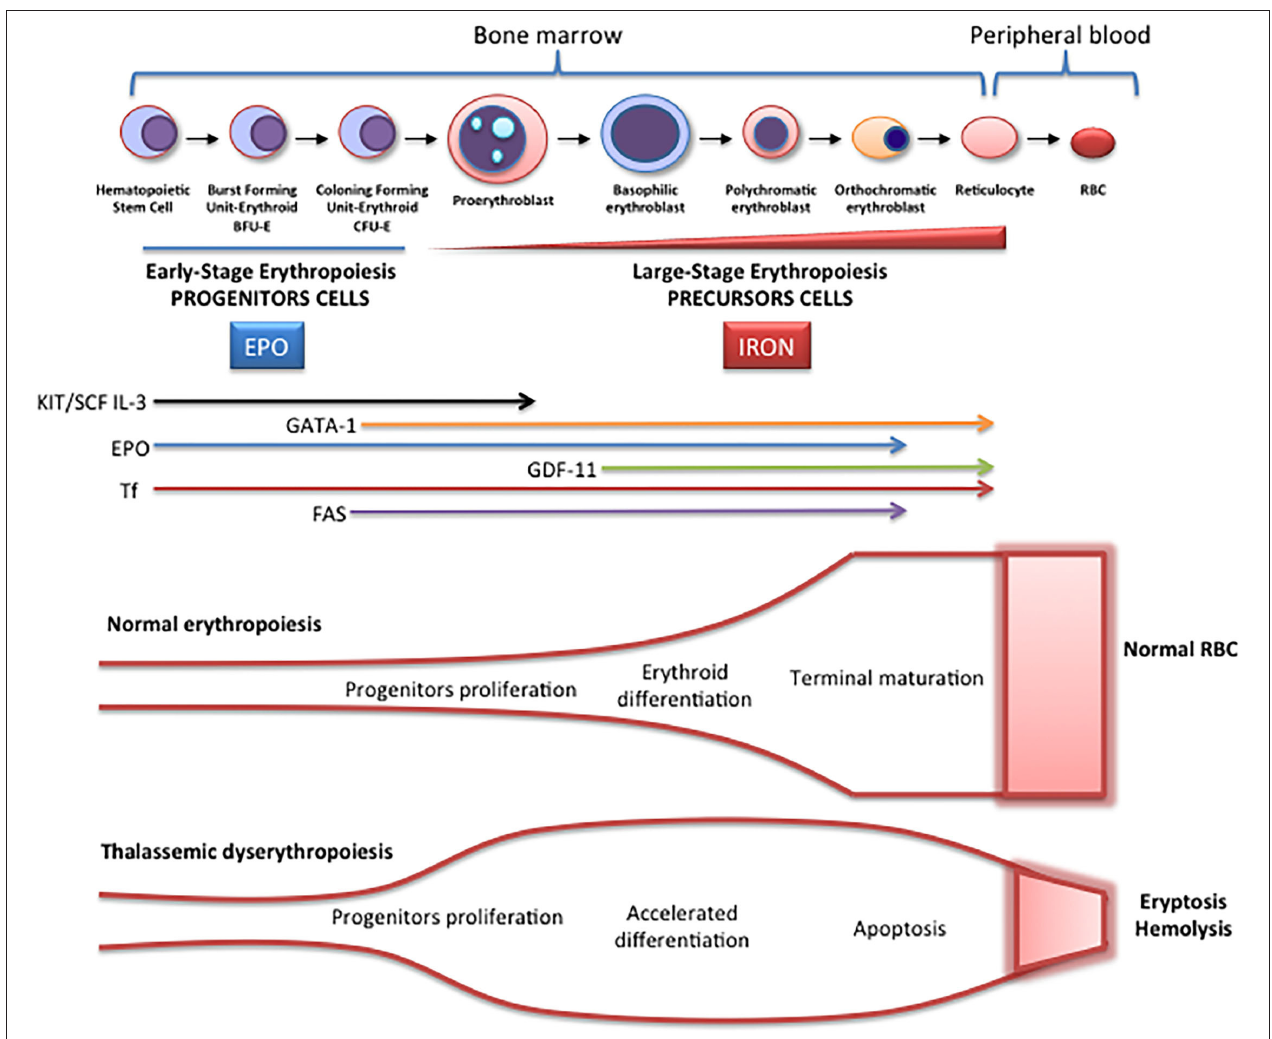
FIGURE 2 | Schematic representation of erythropoiesis. During erythroid development, several stages occur in which a complex network of molecules are expressed (EPO, iron, transcription factors) are involved. In early-stage erythropoiesis, EPO is the main regulator after BFU-E formation. In this stage, GATA-1 promotes erythropoiesis and increases the EPO receptor expression. In large-stage erythropoiesis molecules such as transferrin and growth/differentiating factor 11 (GDF11) are involved. Erythroid expansion is negatively regulated by association of FAS to FAS ligand, which has as a consequence the apoptosis on immature erythroid cells, and GDF11 and other members of the TGF- β family, which negatively regulate erythrocyte differentiation and maturation from the early to the late